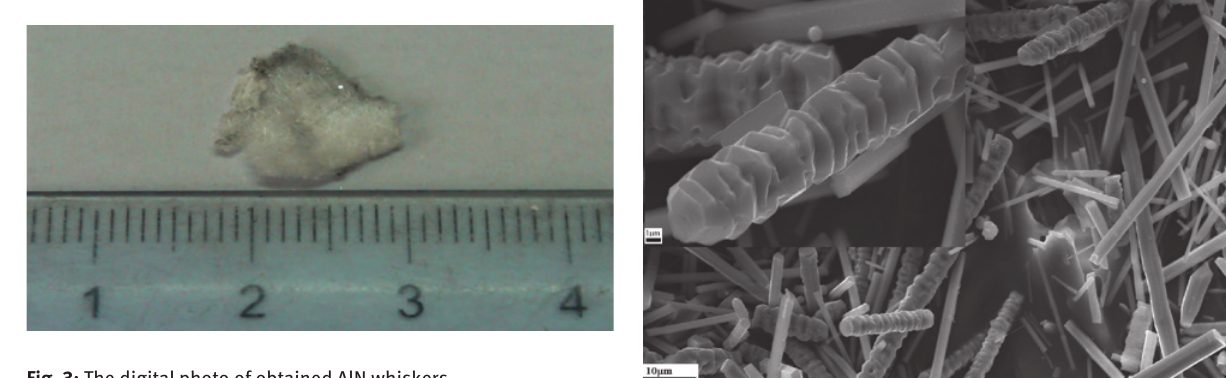
Fig. 3: The digital photo of obtained AlN whiskers